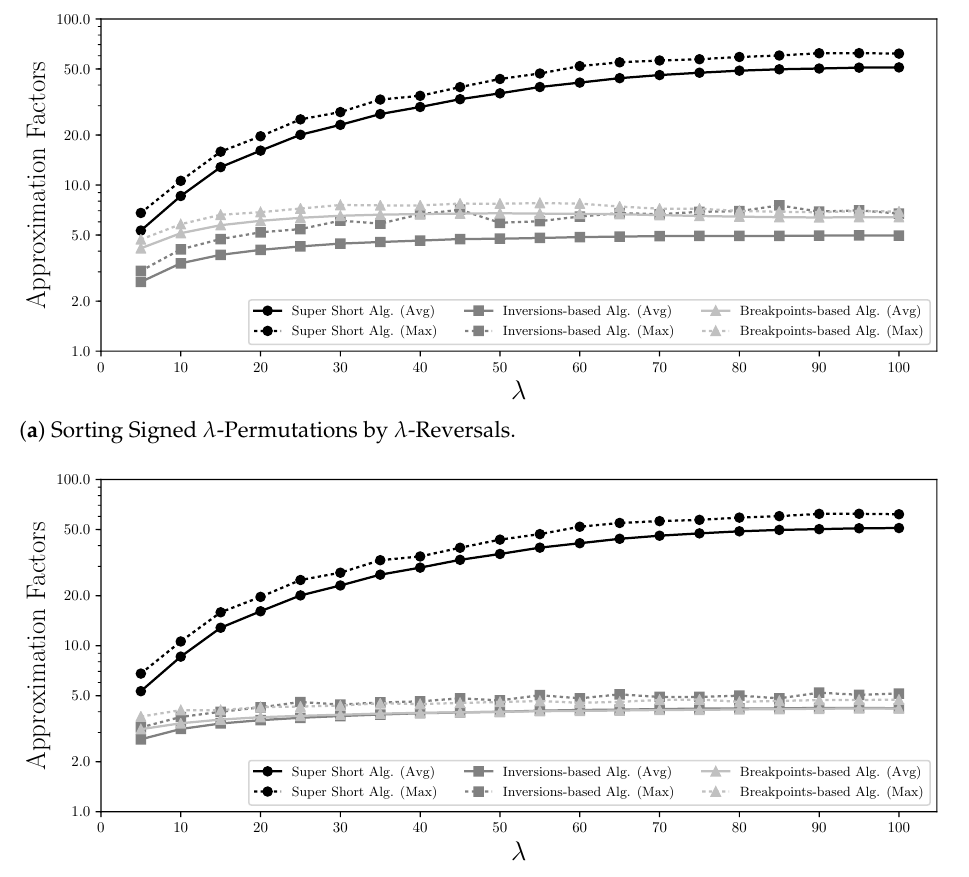
Figure 1. Average and maximum approximation factors of the algorithms for Sorting Signed λ - Permutations by λ -Operations, with totally random λ -permutations of size 100 as inputs. Note that a logarithmic scale is used in the y-axis of each